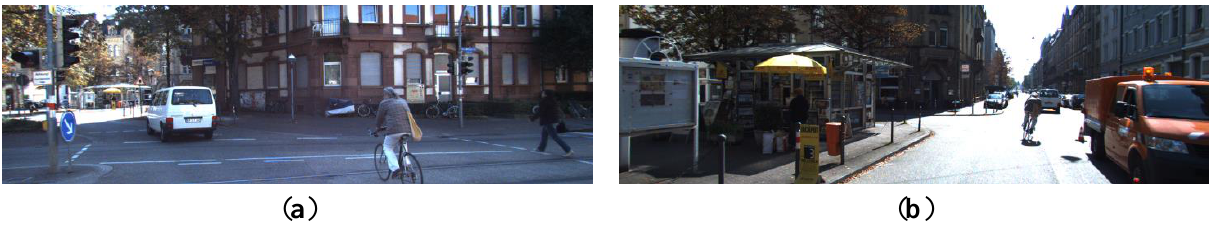
Figure 7. Dataset #5 KITTI; ( a ) first epoch, ( b ) after 10